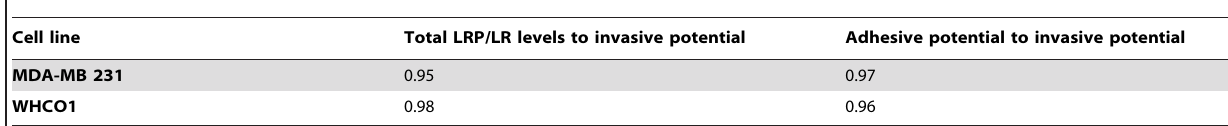
Table 4. Pearson’s correlation